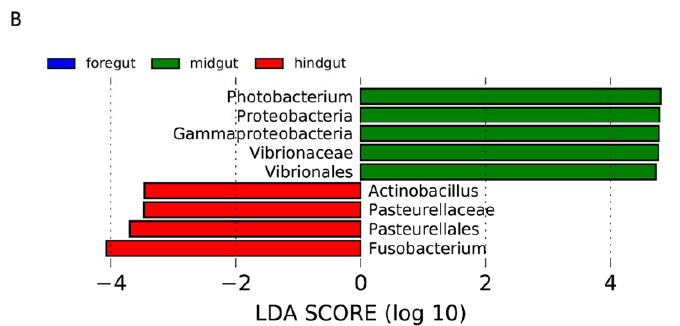
Figure 5. Linear discriminant analysis effect size (LEfSe) for key bacteria (biomarkers) identification for GI tract samples; results are shown in a cladogram ( A ) and histogram ( B ).